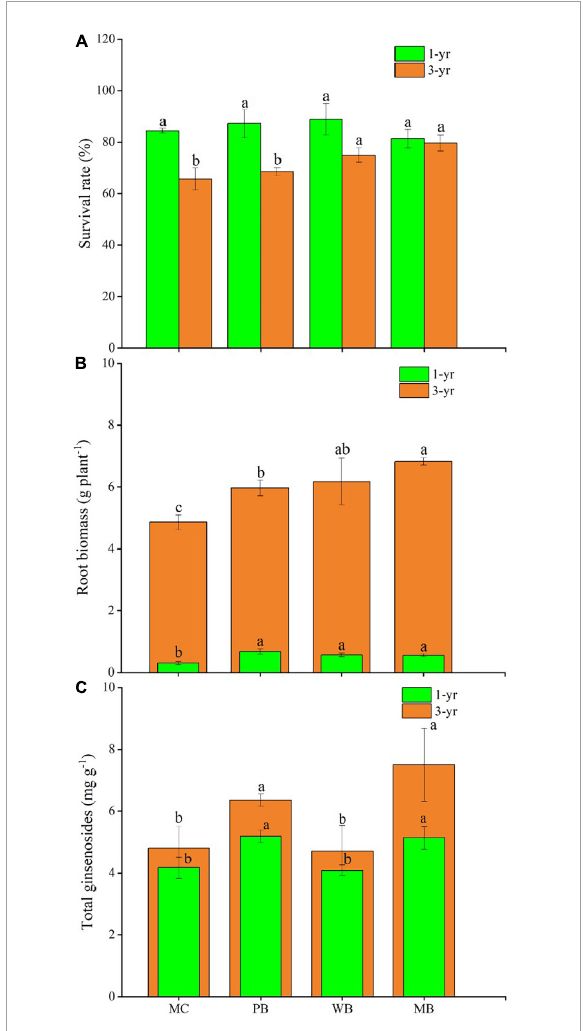
FIGURE2 Survival rate of ginseng seedlings (A) , root biomass (B) , and content of ginsenosides (Li Yang C ) of ginseng on the 1 and 3 year following soil amendment at 20 t ha − 1 . MC, amendment of manure compost at 20 t ha − 1 ; PB, WB, and MB, amendment of pig manure, wood, and maize biochar at 20 t ha − 1 . Different letters above the bars indicated a significant difference among treatments at p <